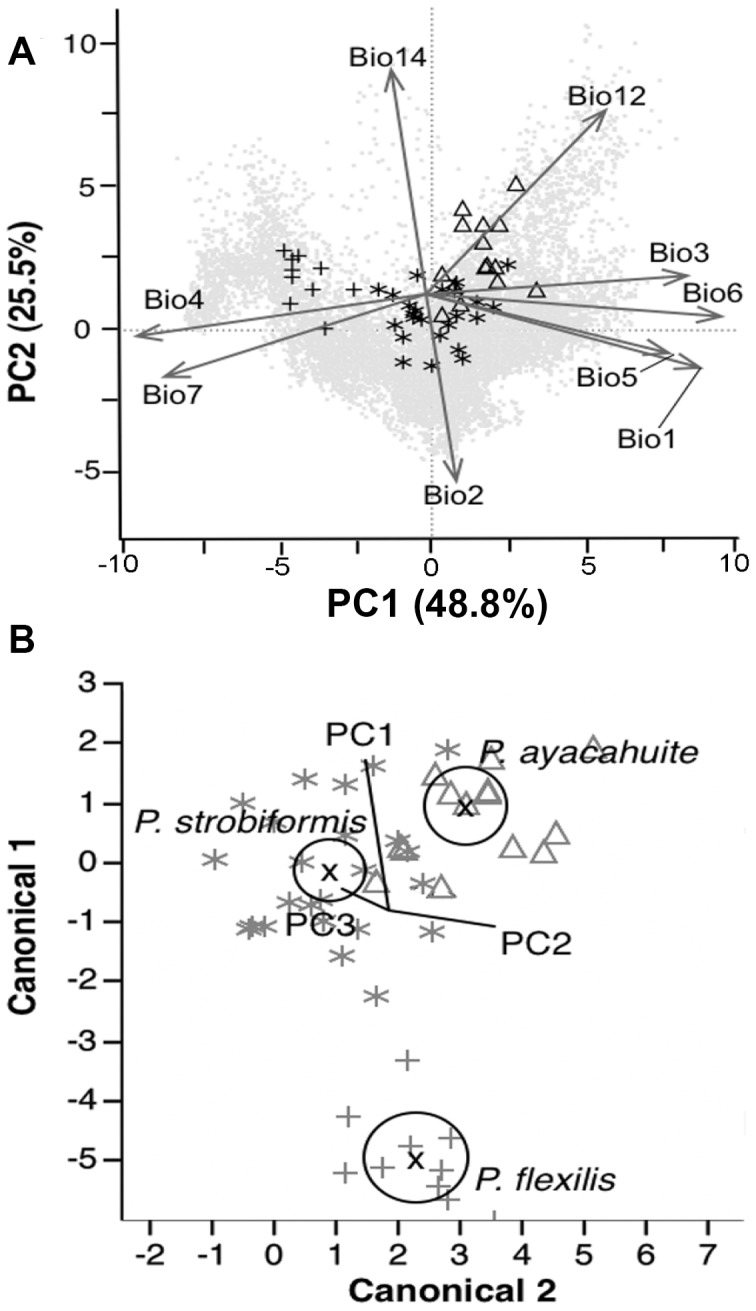
Environmental characterisation of the species complex.(A) Principal component analysis (PCA) of climatic variables for each species and over the entire climate availability (grey dots). The contribution of each component to the total variation is denoted in each axis. Arrows indicate the variables with a higher factor loadings for each component: Bio1: Annual Mean Temperature; Bio2: Mean Diurnal Range; Bio3: Isothermality; Bio5: Max. Temperature of Warmest Month; Bio6: Min. Temperature of Coldest Month; Bio7: Temperature Annual Range; Bio12: Annual Precipitation; Bio14: Precipitation of Driest Month. (B) Canonical analysis of the 3 principal components for the 3 species. Circles represent 95% confidence intervals.